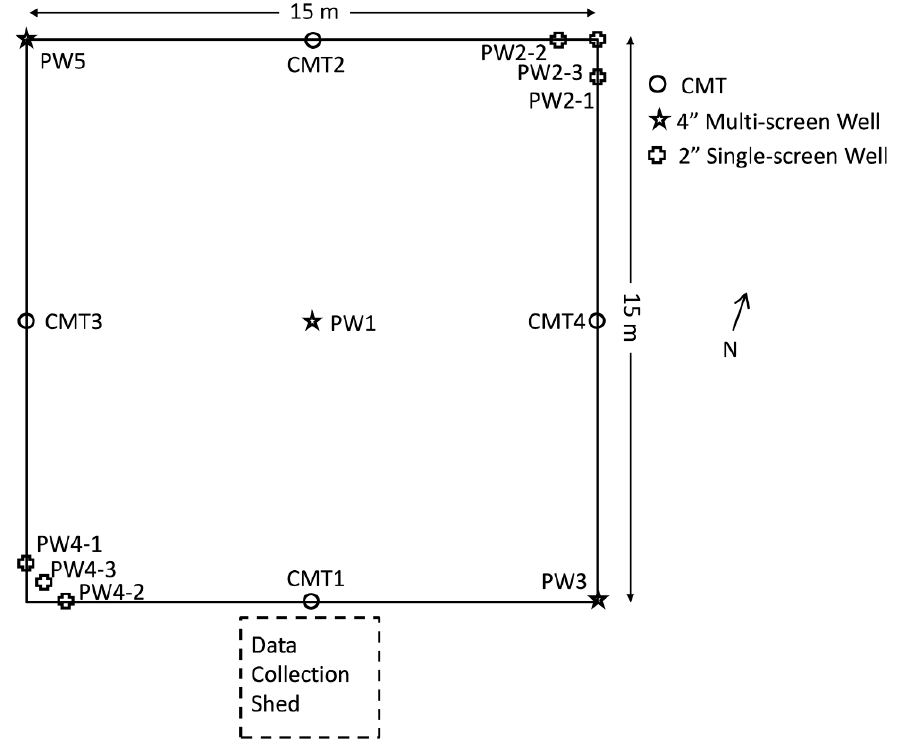
Figure 1. Plan view of the 15 m by 15 m study area showing the well locations. The circles indicate continuous multichannel tubing (CMT) wells, the stars indicate four-inch multiple screen pumping wells (PW), and the crosses indicate two-inch well nests (from [18]).